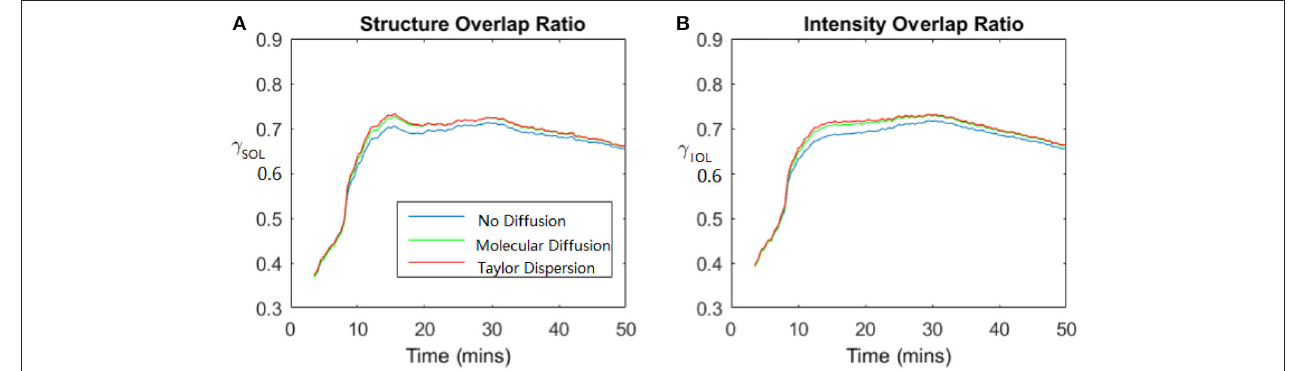
FIGURE 6 | Dynamic process of dispersion: the value of the overlap ratio evolves with time. Total time duration is 50 mins. (A) Shows the structure overlap ratio (derived from black and white images) evolution with time and (B) shows the intensity overlap ratio (derived from grayscale images) evolution with time. Blue lines show the comparison between experimental results and simulation with no diffusion, green lines with molecular diffusion and red lines with Taylor dispersion.